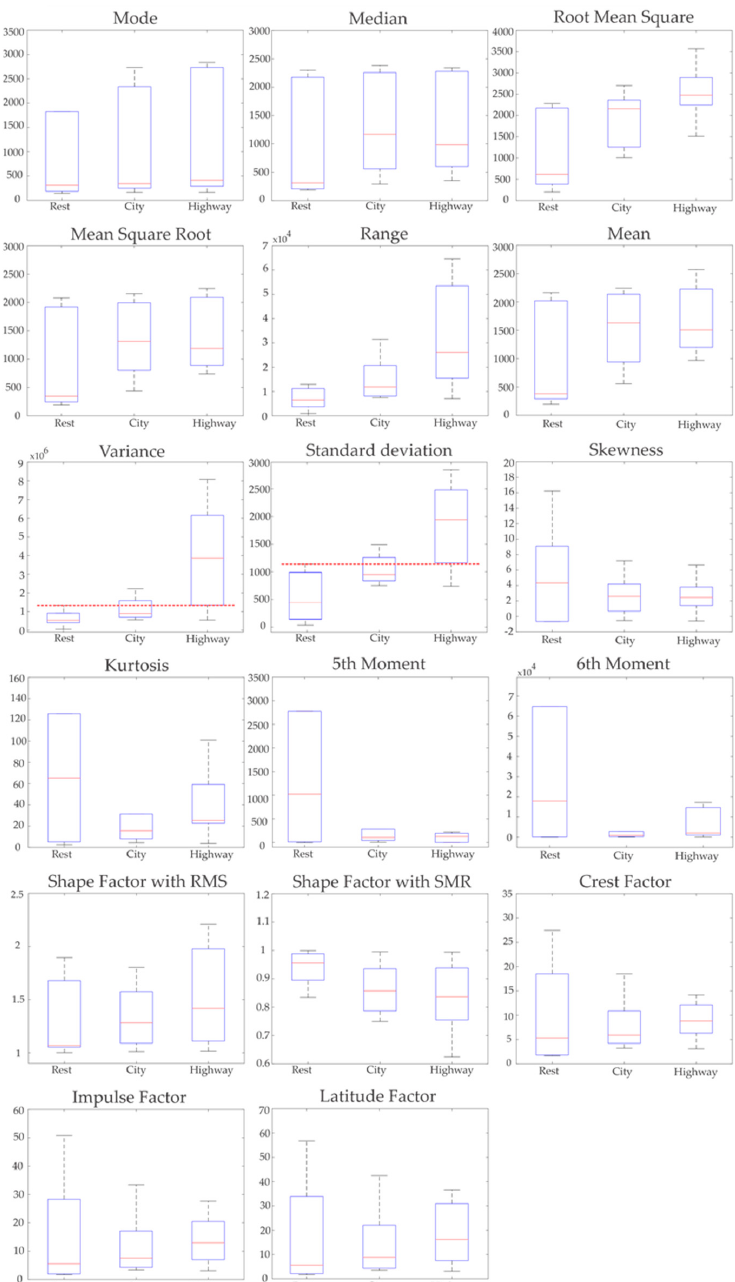
Figure 6. Box diagrams of the 17 STFs of the three periods without normalization.